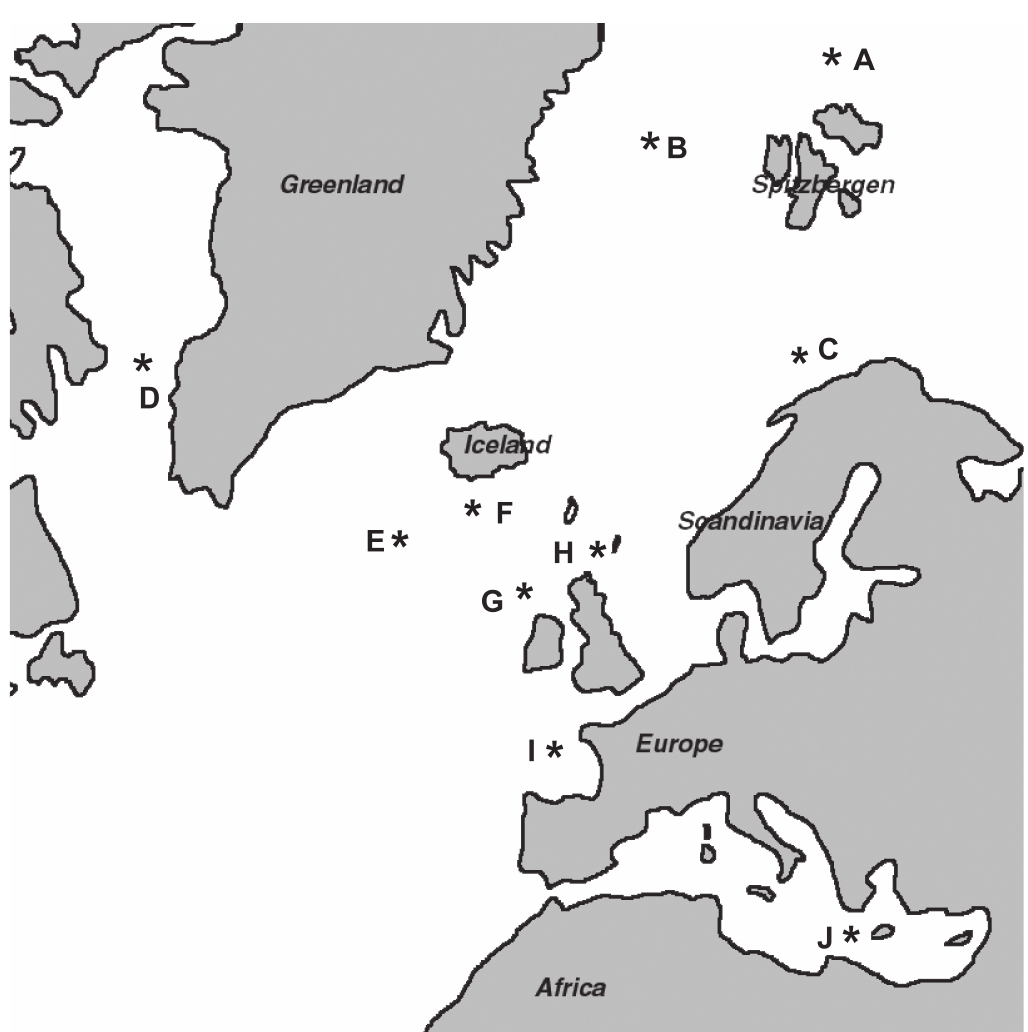
Fig. 1. Type localities of North Atlantic species of Lepechinella and Lepesubchela . A . Lepechinella arctica. B . Lepechinella eupraxiella. C . Lepechinella norvegica sp. nov. D . Lepechinella schellenbergi . E . Lepechinella helgi/skarphedini/grimi. F . Lepechinella victoriae sp. nov. G . Lepesubchela